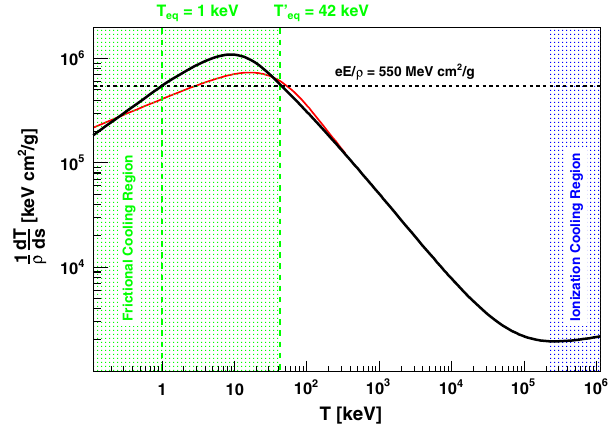
FIG. 1. Stopping power of helium for (cid:1) þ (black, velocity scaled from [13]) and (cid:1) (cid:1) (red, velocity scaled from [14]) where it deviates from (cid:1) þ , and the acceleration power of an electric field of fixed strength E for a particle of constant unit charge as functions of particle energy T